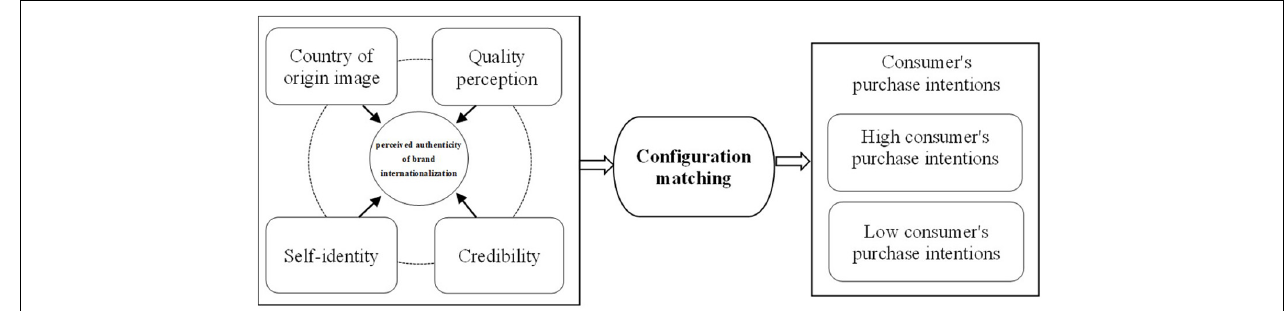
FIGURE 1 | Theoretical framework.